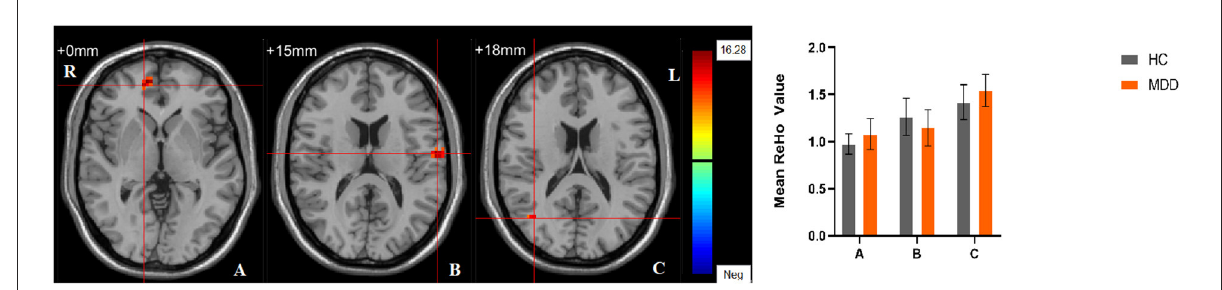
FIGURE4 The main effect of diagnostic group. Regions with a main effect of the diagnostic group included (A) The right superior medial frontal gyrus; (B) The left postcentral gyrus; (C) The right middle temporal gyrus (cluster-level threshold of p < 0.05 after GRF correction). The color bar represents the range of F values. R = right, L = left. The graph shows the ReHo values (mean ± standard deviation) extracted from regions with a main effect of diagnostic group. The Y-axis represents ReHo values. The X-axis represents regions with a main effect of the diagnostic group.